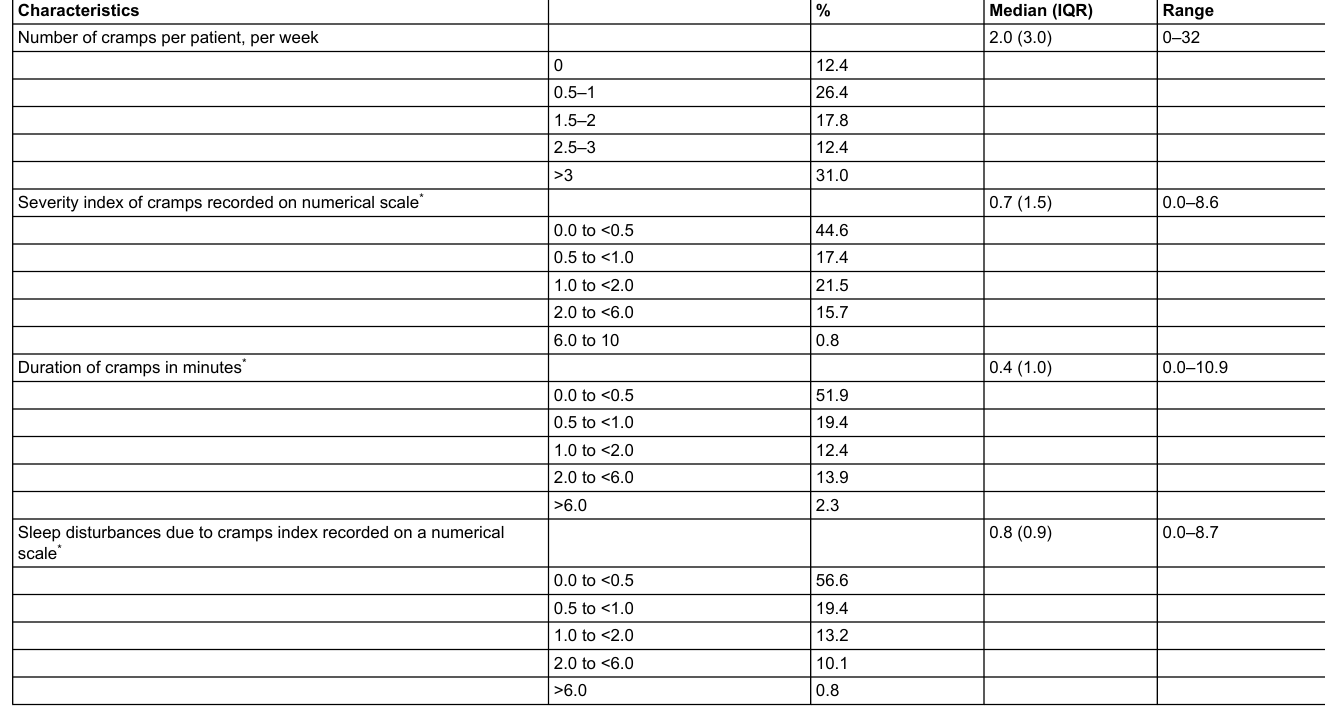
Table 2: Main features of patients’ cramps (n = 129 patients). Characteristics